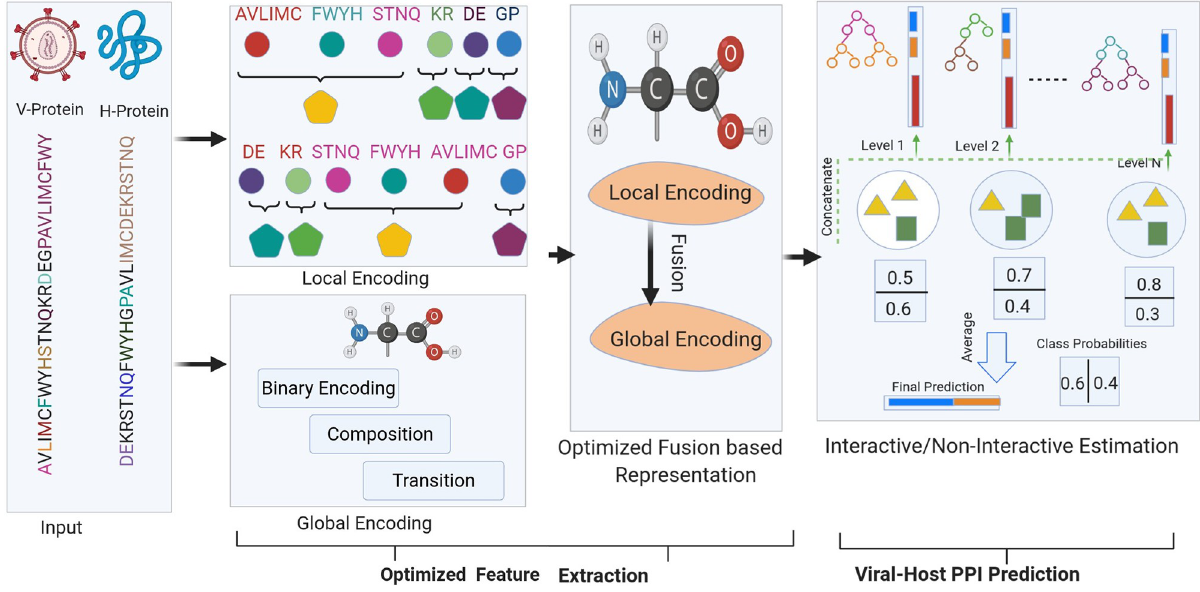
Fig 2. The workflow of proposed “LGCA-VHPPI” viral-host PPI predictor. First Block Represents Input Module, Second Block Shows the Paradigm of Local and Global Encoding, Third Block Integrates Local and Global Encodings, and Last Block Reveals the Probabilistic Paradigm of Deep Forest.